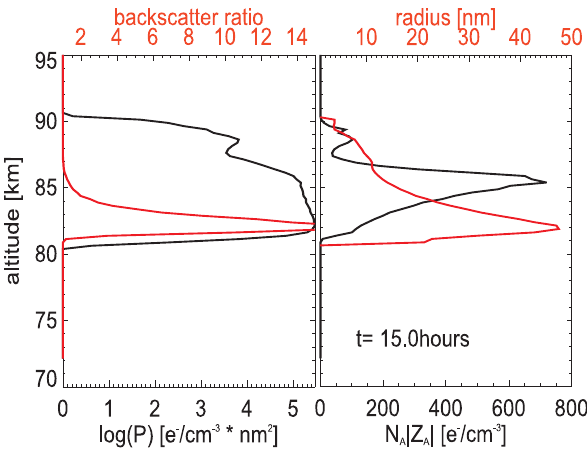
Fig. 2. Model results of the proxy P (black,left), the calculated backscatter ratio that would be seen by a lidar operating at a wave- length of 532nm (red, left), the charged particle number density (black, right) and the aerosol particle radius (red, right). This figure is reproduced from Rapp et al. (2003), copyright by the American Geophysical